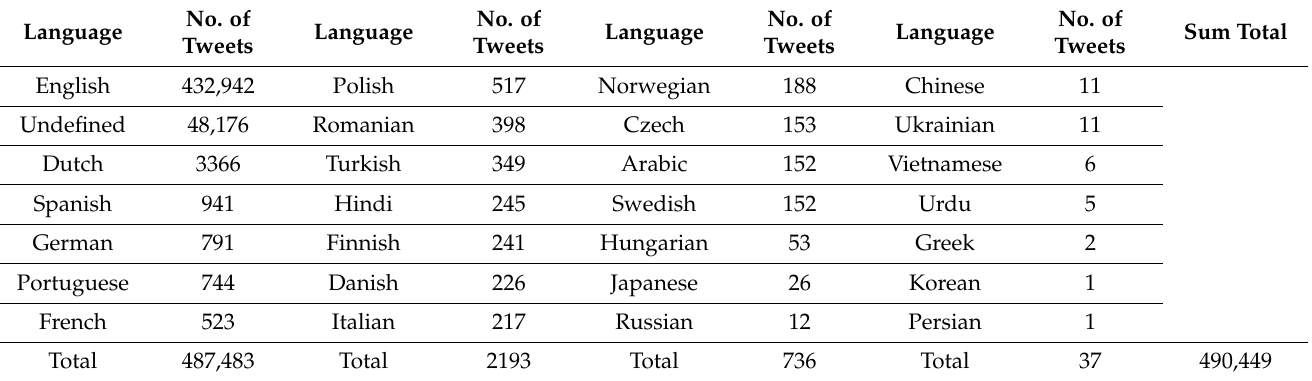
Table 2. Distribution of Tweets by language.